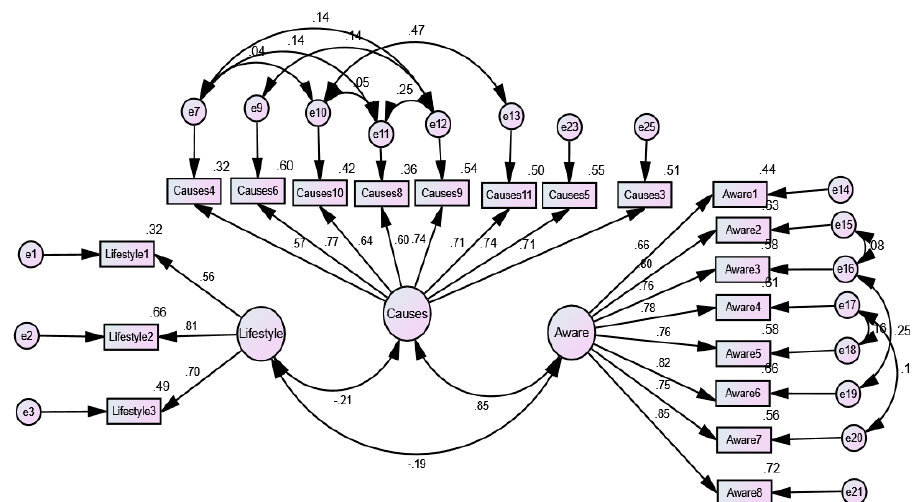
Figure 1. A Three-Factor Structural Model for Collegiate Aviation Fatigue (Model VIII). (.xx means